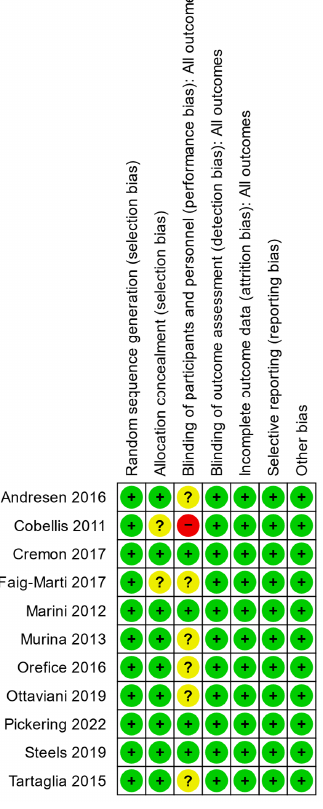
Figure 2. Summary of risk-of-bias assessments for individual articles included in the systematic review. Green +: low risk of bias, yellow ?: unknown risk of bias; red -: high risk of bias.